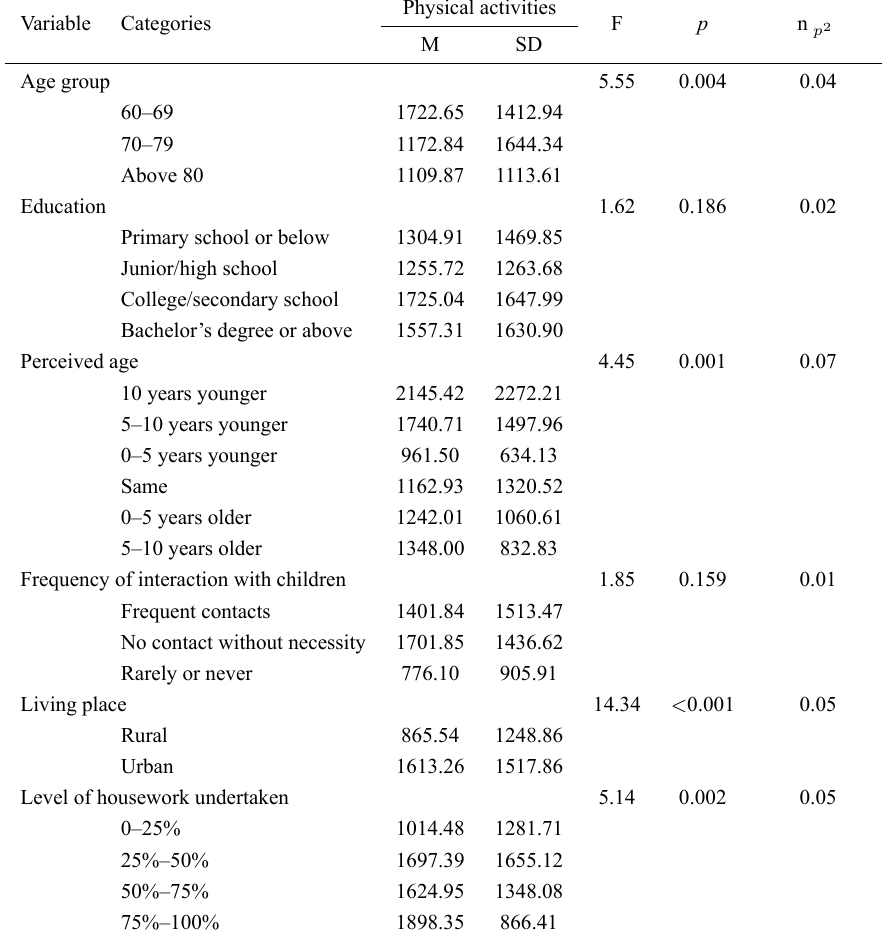
Table 3. Physical activity of participants in different characteristics groups.